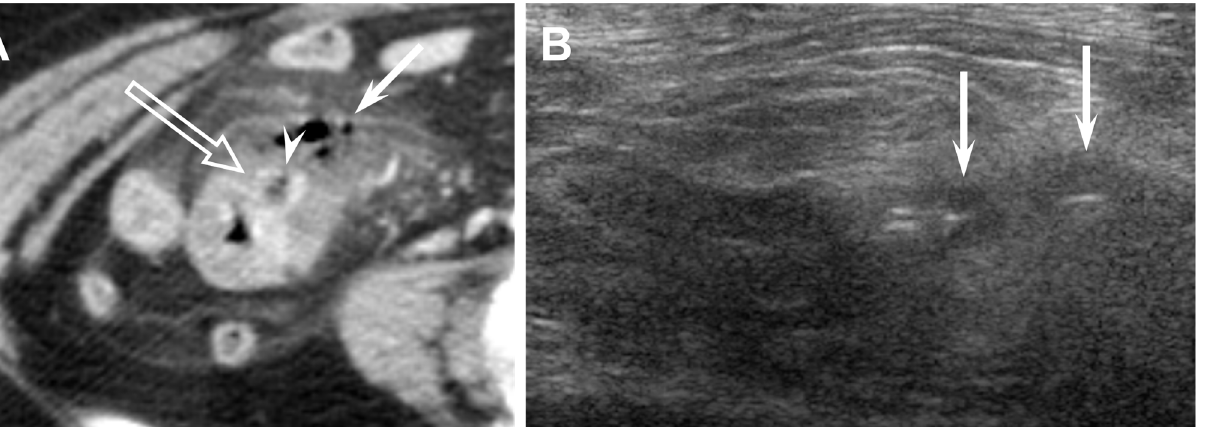
Figure 5. Seventy-year-old female (patient #7) with acute perforated ileal diverticulitis. ( A ) Axial CT scan shows terminal ileal wall thickening, an outpouching in fl amed diverticulum (open arrow) with focal wall defect (arrowhead) at the mesenteric side of terminal ileum, extraluminal air with fl uid (arrow), and mesenteric fat in fi ltration. ( B ) US scan with linear transducer also reveals extraluminal air bubbles (arrows) representing perforation.